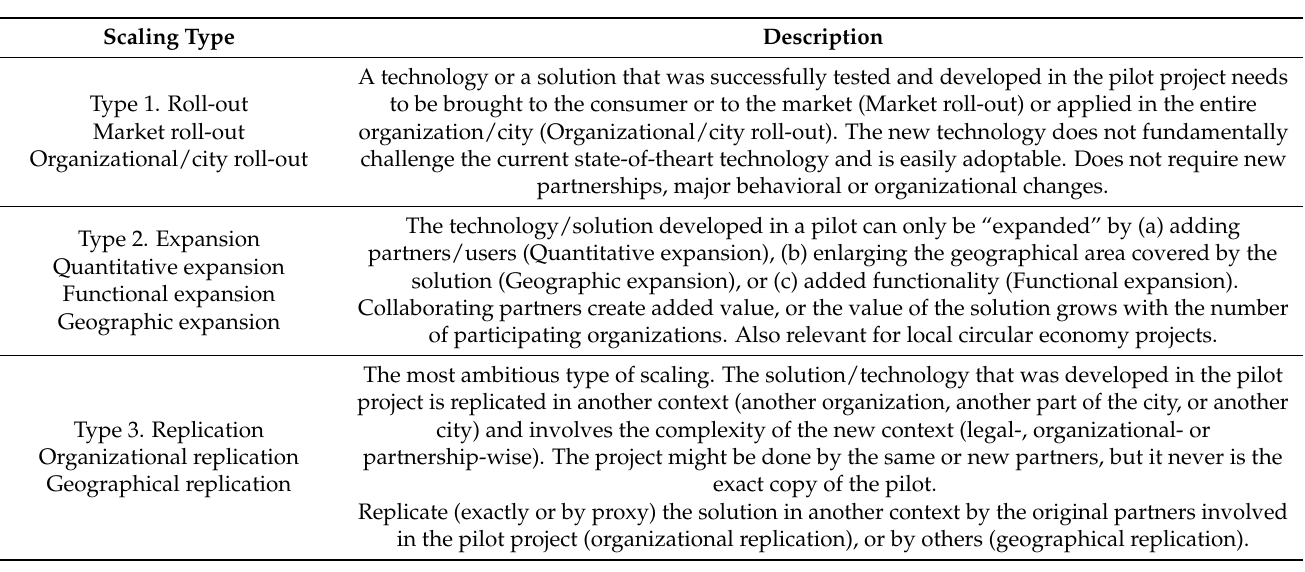
Table 1. Replication types of smart city solutions (W. van Winden).